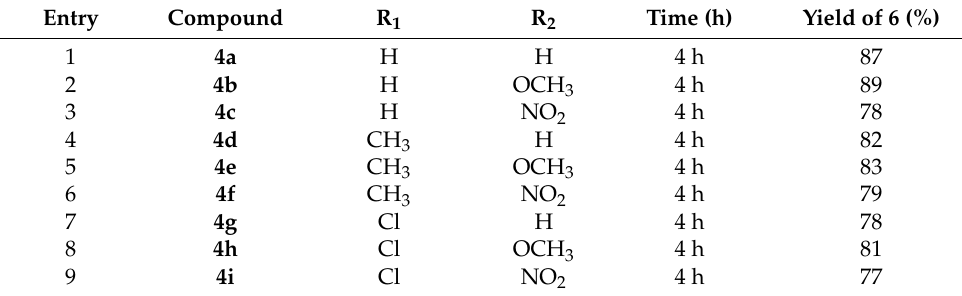
Table 2. One-pot synthesis of 1,4-disubstituted 1,2,3-triazole 4a – i .